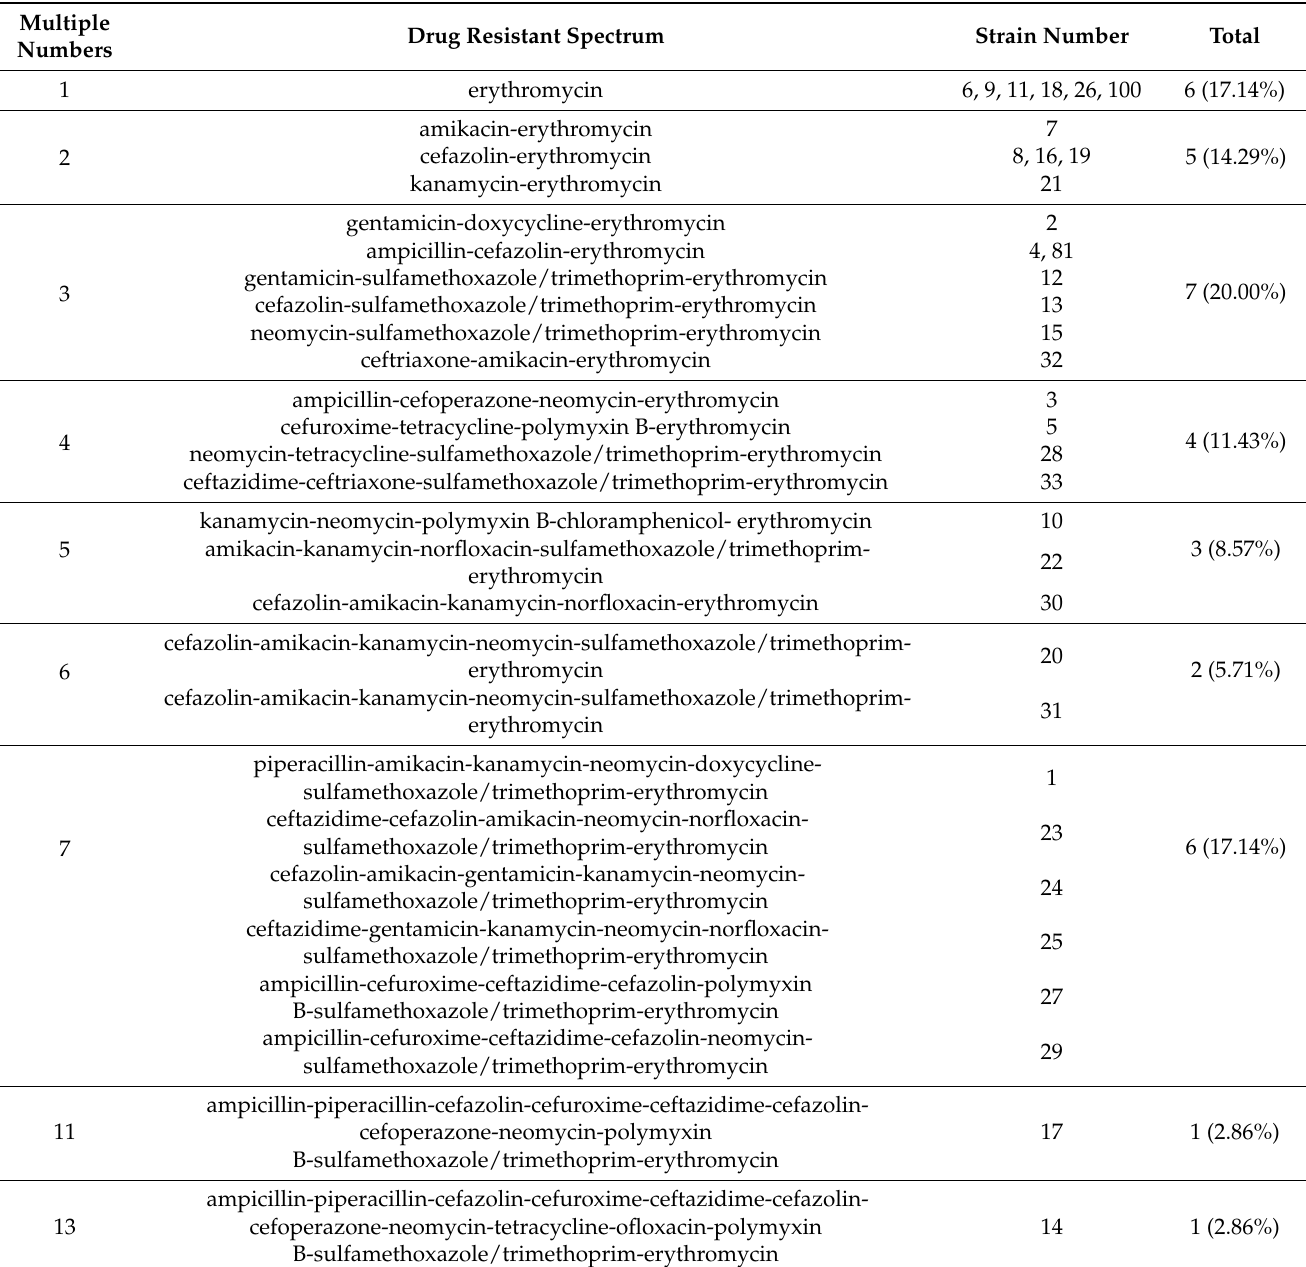
Table 4. Antibiotic resistance profile analysis of Cronobacter